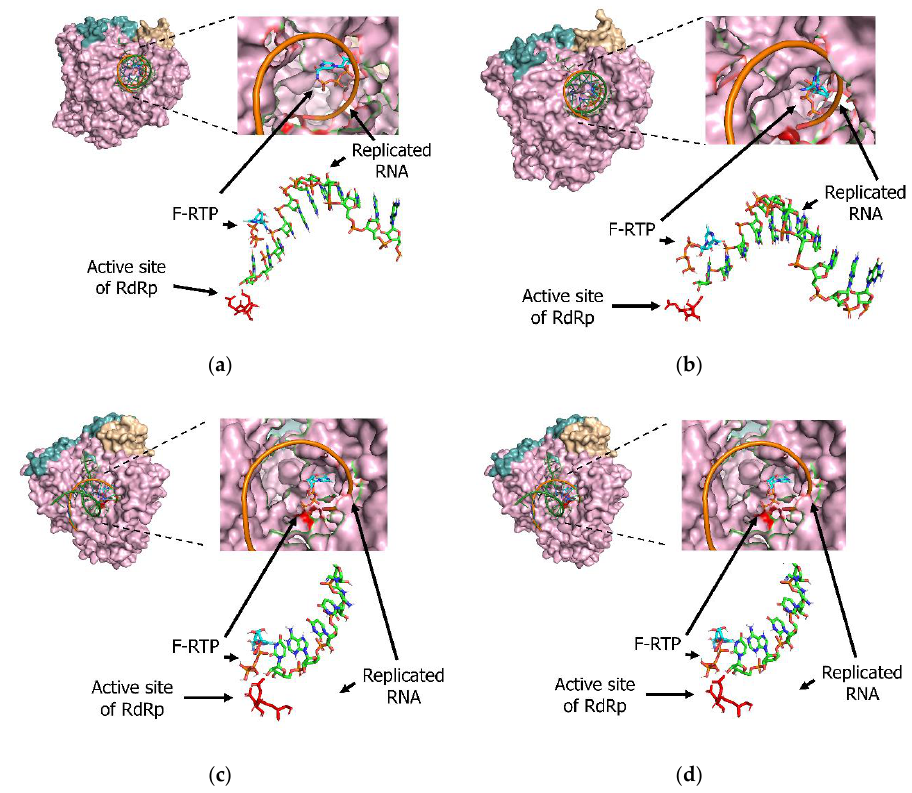
Figure 2. Detailed interactions among favipiravir ribofuranosyl-5′-triphosphate (F-RTP), nucleotide triphosphate (NTP), ions, and the active sites (red-colored regions) of ( a ) influenza H1N1, ( b ) severe acute respiratory syndrome coronavirus-2 (SARS-CoV-2), ( c ) SARS-CoV, and ( d ) Middle East respiratory syndrome coronavirus (MERS-CoV) RNA-dependent RNA polymerases (RdRp). Three-dimensional configurations of F-RTP, NTP, ions, and RdRp protein were constructed with space-filling or stick models.